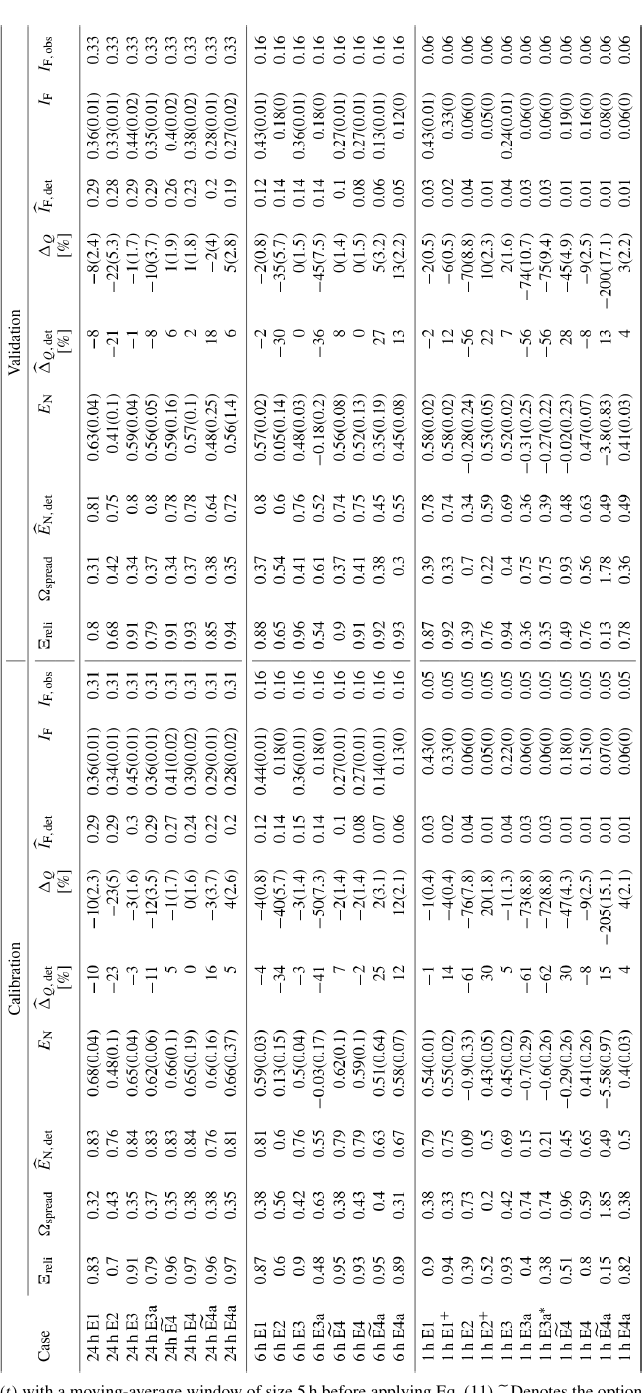
Table B1. Murg: summary of the predictions in the calibration and the validation period made with error models E1–E4 for different temporal resolutions of the hydrological data. Values are medians (and standard deviations) of the quality indices of the deterministic model output for the maximum posterior parameters, as well as those of 500 streamflow realisations produced with the full posterior parameter distributions. Recall that smaller values of (cid:52) reli and (cid:127) spread indicate better